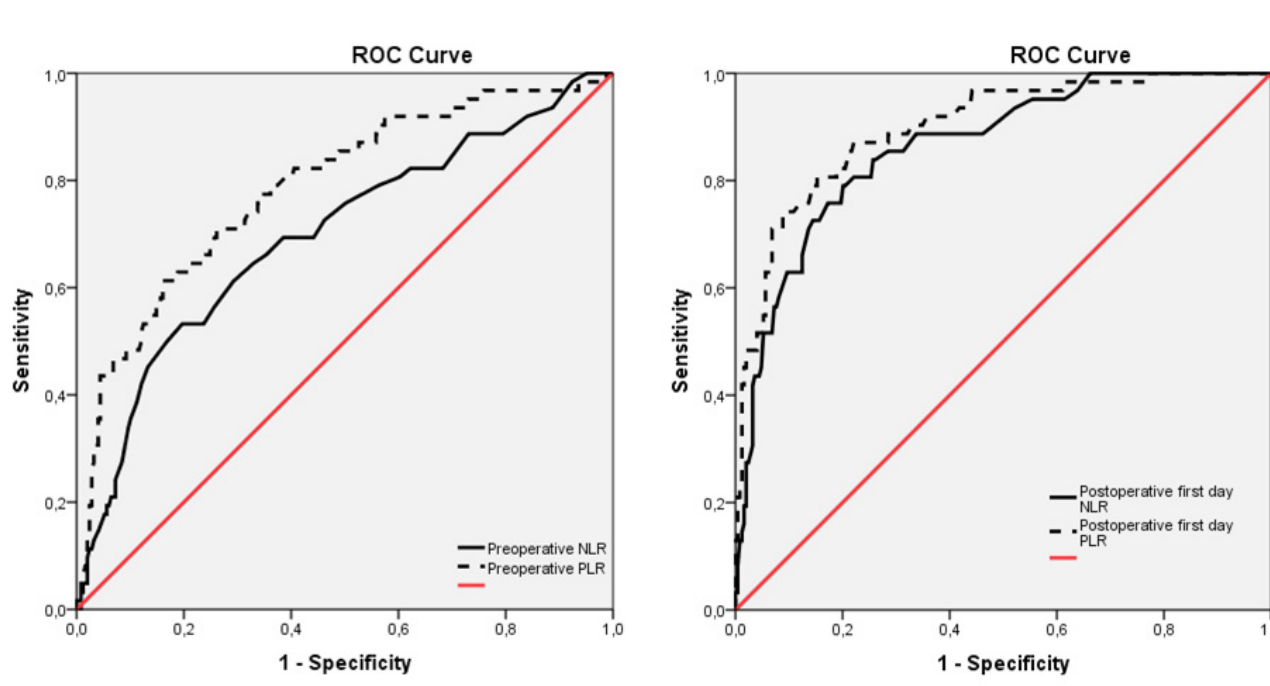
Fig. 2 - ROC curve analysis or postoperative first day PLR and NLR regarding occurrence of postoperative AKI.